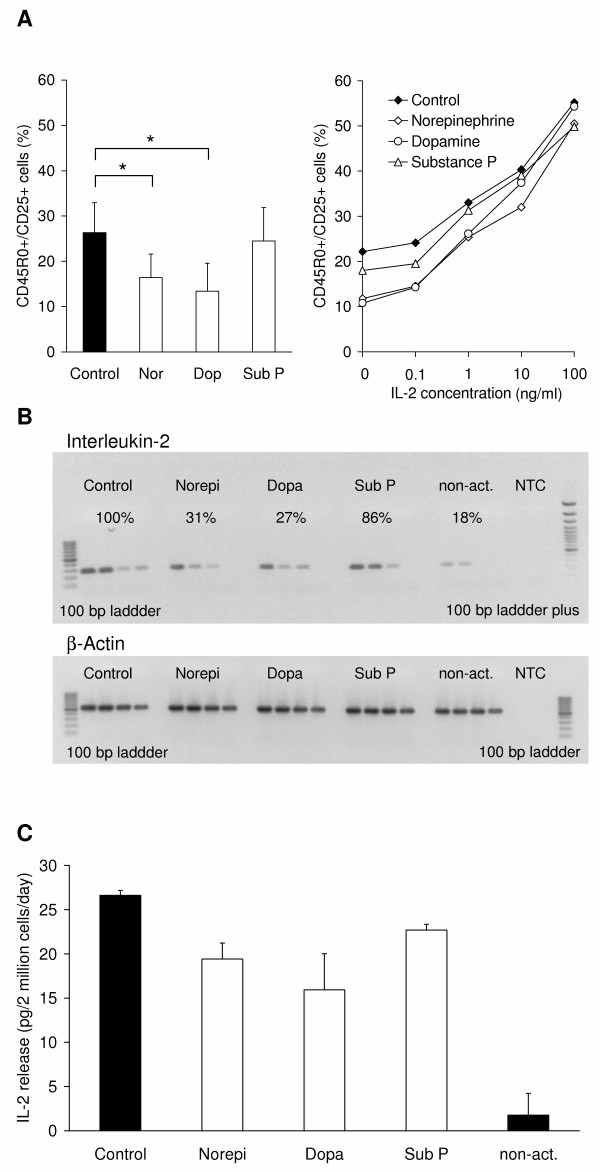
Activation of CD8+ T lymphocytes with anti-CD3 and anti-CD28 antibodies. The activation status was detected by double-staining for the activation markers CD25 and CD45R0. (A) Flow-cytometrical analysis of CD8+ T lymphocytes activated in the presence of neurotransmitters (10 μM norepinephrine, 1 μM substance P and dopamine). The graph shows the mean values and standard deviation of double-positive T lymphocytes of four independent experiments with cells from different donors. Asterisks mark statistically significant changes (p < 0.05). Stepwise addition of external IL-2 reverses the inhibitory effect of the neurotransmitters, but in turn leads to a higher number of CD25+ CD45RO+ lymphocytes. (B) Expression of IL-2 RNA during activation under the influence of neurotransmitters. RT-PCR was performed with cDNA in the dilution steps 1:125 1:625 1:3125 and 1: 15625. Per lane, 10 μl of PCR sample were applied to the agarose gel. Beta-actin expression was used as house-keeping gene. (C) The release of IL-2 by CD8+ lympocytes during activation in the presence of neurotransmitters was measured by using an enzyme-linked immunoassay. The graph shows mean values and standard deviation of three independent experiments with cells from different donors.